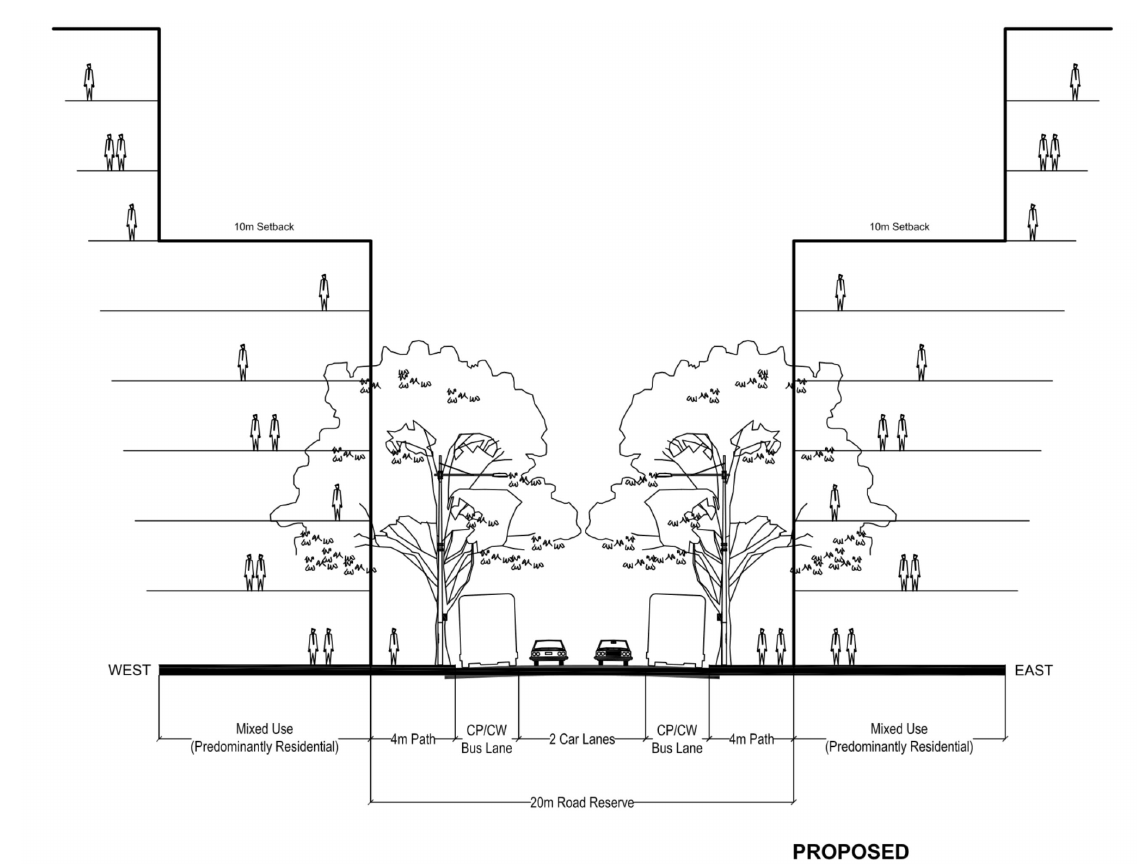
Figure 2. Proposed design for the connector road (Boundary Road). Source: Arden Macaulay Structure plan 2012. This drawing shows the proposed street wall (zero lot building façade) and the conflict it has with the canopies of proposed